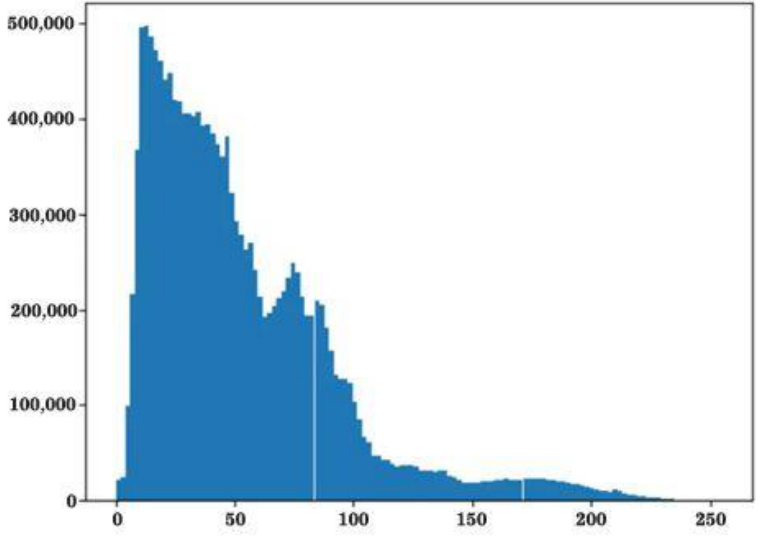
Figure 8. Histogram of the sampled image.